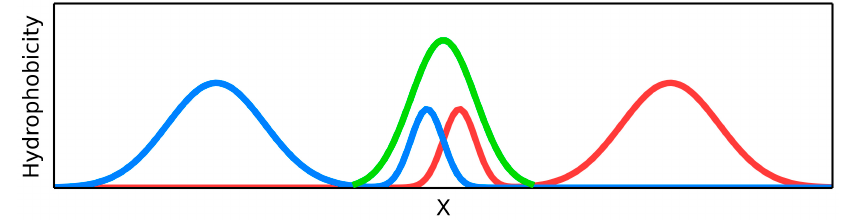
Figure 14. Schematic representation of the interface-domain formed by both chains in the interface area. Blue and red lines: ndividual chains, Green line: the additional domains generated by fragments of individual chains.